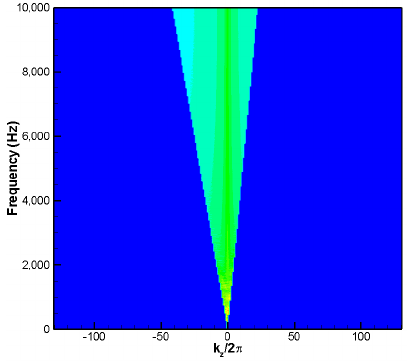
Figure 14. Region of compressible pressure fluctuation component for m = 0 mode.